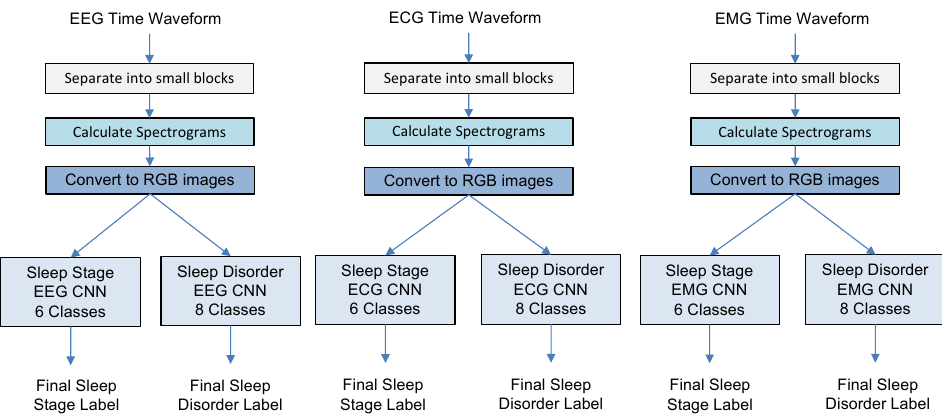
Figure 1. Experiment 1: Sleep stage and sleep disorder classification using a baseline